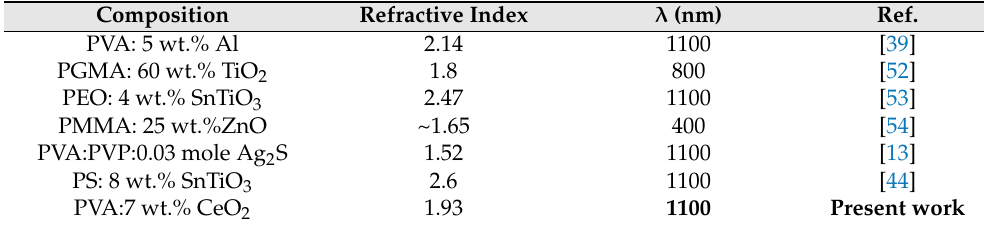
Table 4. Refractive index values of various polymer composite systems.